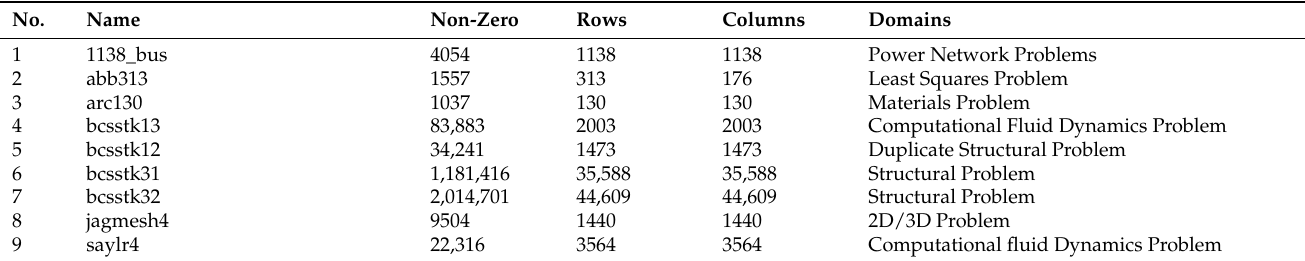
Table 2. Application